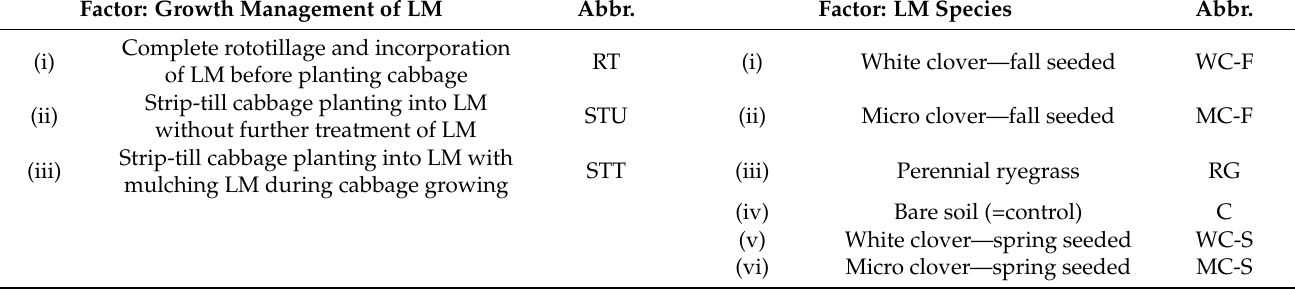
Table 1. Overview of treatments within main-plot factor growth management of LM and sub-plot factor LM species with abbreviations.